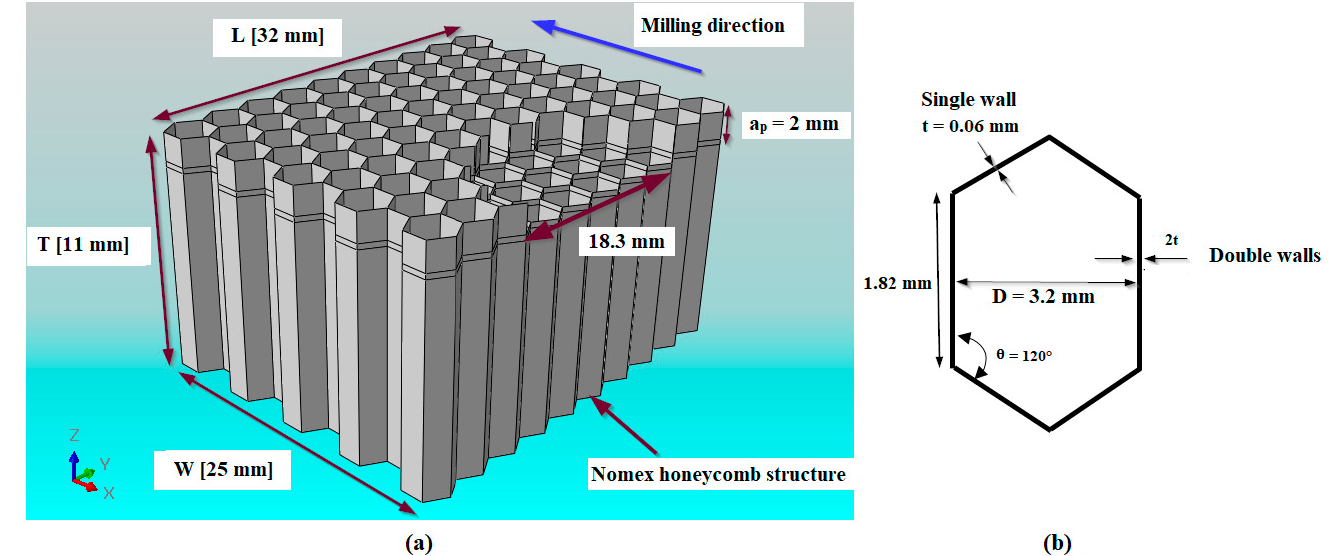
Figure 1. ( a ) Dimensions of the honeycomb structure; ( b ) dimensions of the hexagonal cell.